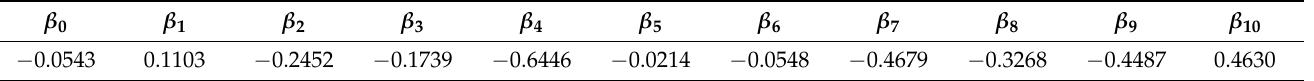
Figure 15. Partial autocorrelation function of time series composed of 1 and − 1 values for original displacements. Table 22. Coefficients of AR(10) process for M4 x -original displacements.